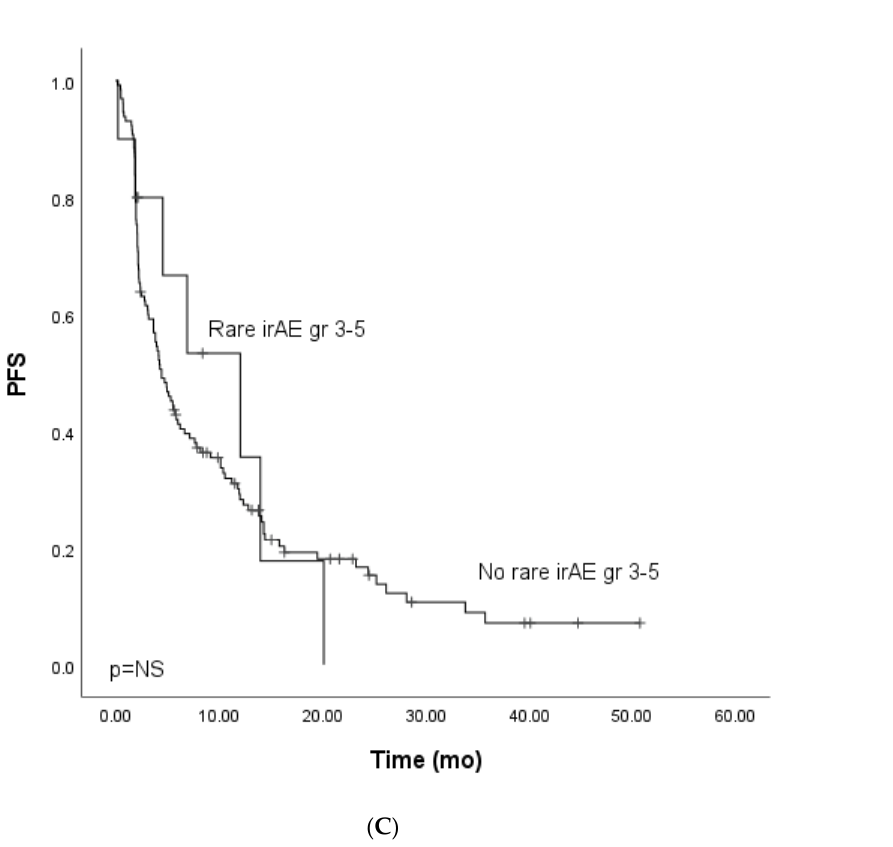
Figure 1. Kaplan–Meier analysis for progress-free survival for patients with ( A ) grade ≥ 3 immune-related adverse events; ( B ) grade ≥ 3 dermatological or endocrinological immune-related adverse events; ( C ) rare grade ≥ 3 immune-related adverse events. Crosses indicate censored events.